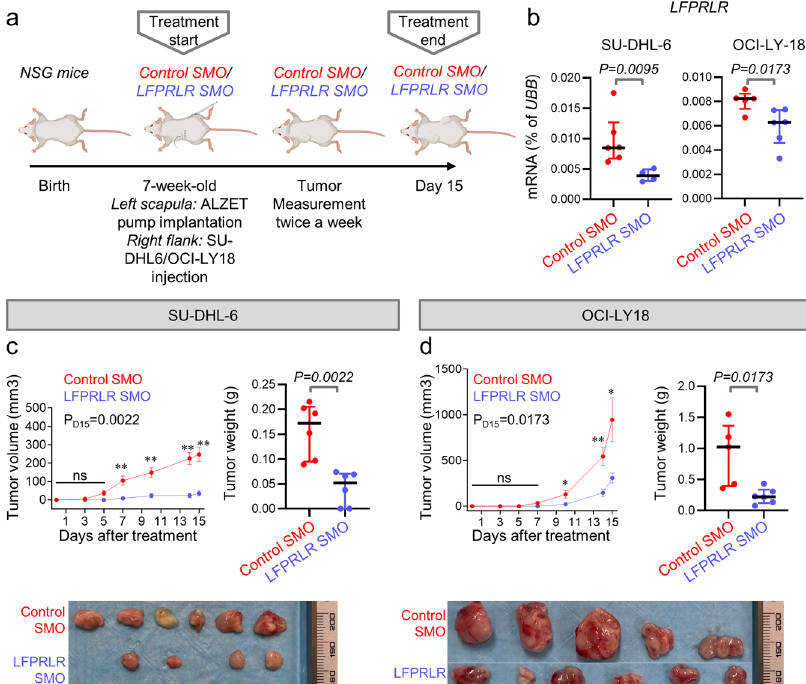
Fig. 6 Knockdown of LFPRLR reduces progression of overt human DLBCL in vivo. a Experimental design for measuring the in vivo ef fi cacy of LFPRLR SMO in reducing progression of overt human DLBCL in malignant B-cell line derived xenograft (CDX) models. b qPCR validation of LFPRLR knock down in tumors isolated from euthanized transplant recipient mice treated with control SMO ( n = 6 for SU-DHL-6 and n = 5 for OCI-LY18, red) or LFPRLR SMO ( n = 4 for SU-DHL-6 and n = 6 for OCI-LY18, blue) on day 15. Each dot in qPCR analyses of transcripts corresponds to the mean expression of that gene in tumors from one CDX recipient mouse calculated from 3 technical replicates. UBB was used as the house-keeping gene in qPCR. c , d Change in tumor volume and tumor weight on the day of euthanasia (day 15) in NSG mice that received subcutaneous injections of 7 × 10 6 malignant human B cells [SU- DHL-6 ( c ) and OCI-LY18 ( d )] and were treated with control SMO ( n = 6 for SU-DHL-6 and n = 5 for OCI-LY18, red) or LFPRLR SMO ( n = 6 for SU-DHL-6 and n = 6 for OCI-LY18, blue). Tumor volume panels in ( c , d ) show mean ± SEM. All other graphs show median ± interquartile range. Exact p -values were calculated using the Mann – Whitney U test. ns non-signi fi cant, *0.01 < p < 0.05, **0.001 < p < 0.01. a was created with